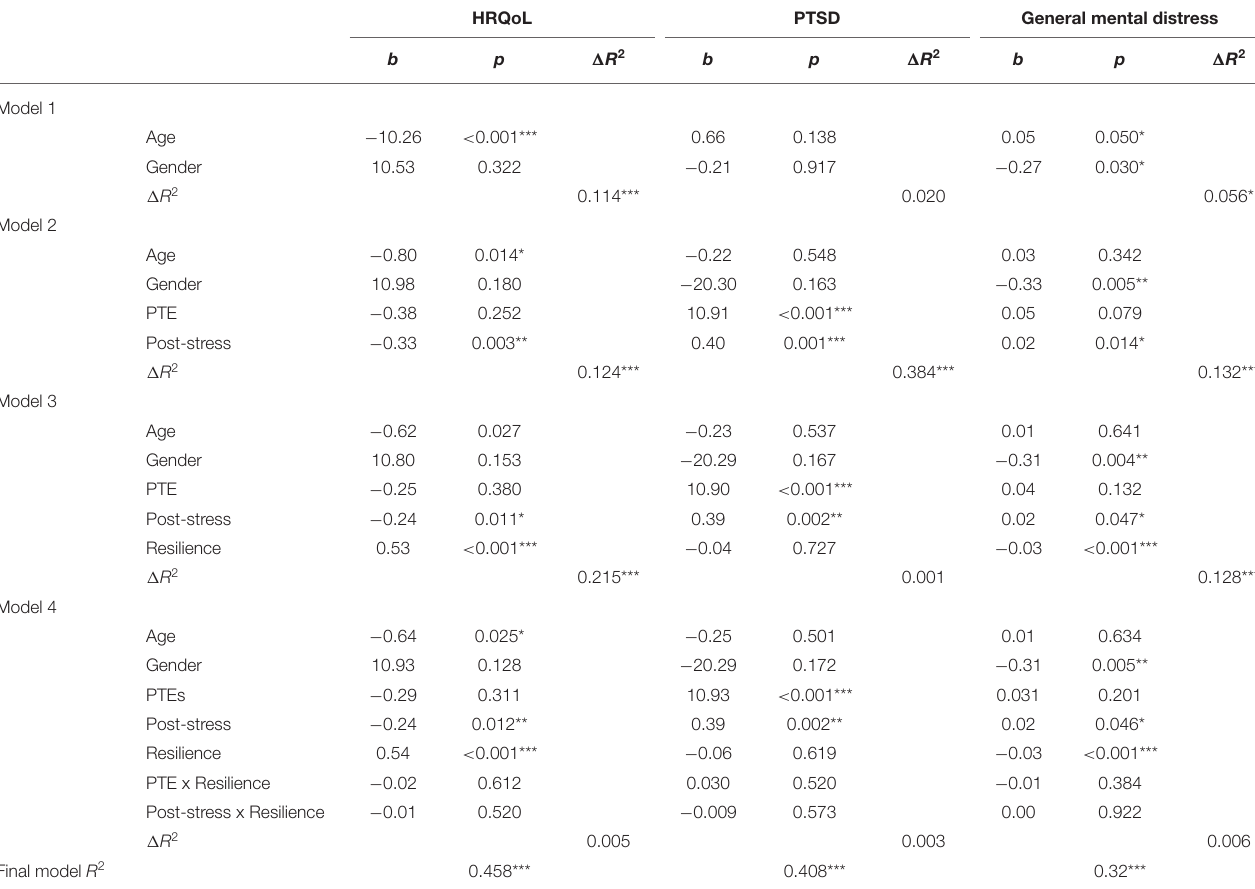
TABLE 3 | Multiple regression for resilience effects on HRQoL, PTSD, and general mental distress. HRQoL PTSD General mental